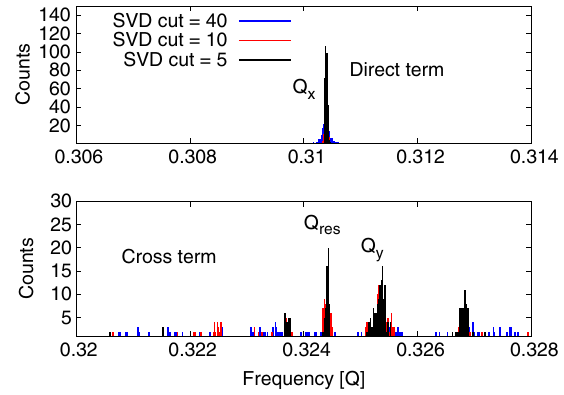
FIG. 10. Tune distribution of all LHC BPMs of the direct (top) and cross (bottom) terms of the amplitude detuning. While the direct term is cleanly measured and gives a single peak, several spectral lines appear on the cross term data making it difficult to identify the natural tune